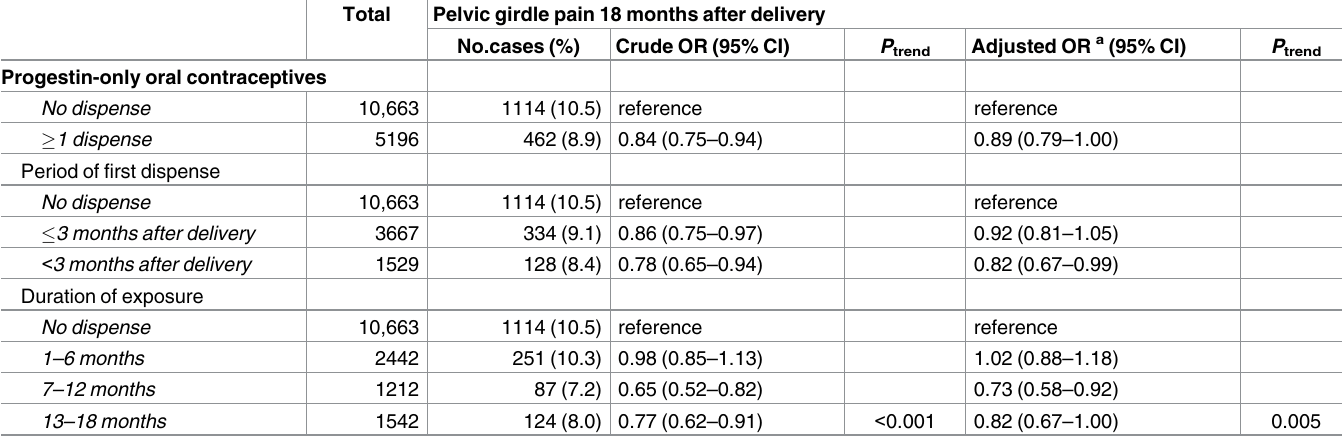
Table 4. Associations of progestin-only oral contraceptives and pelvic girdle pain 18 months after delivery (N =